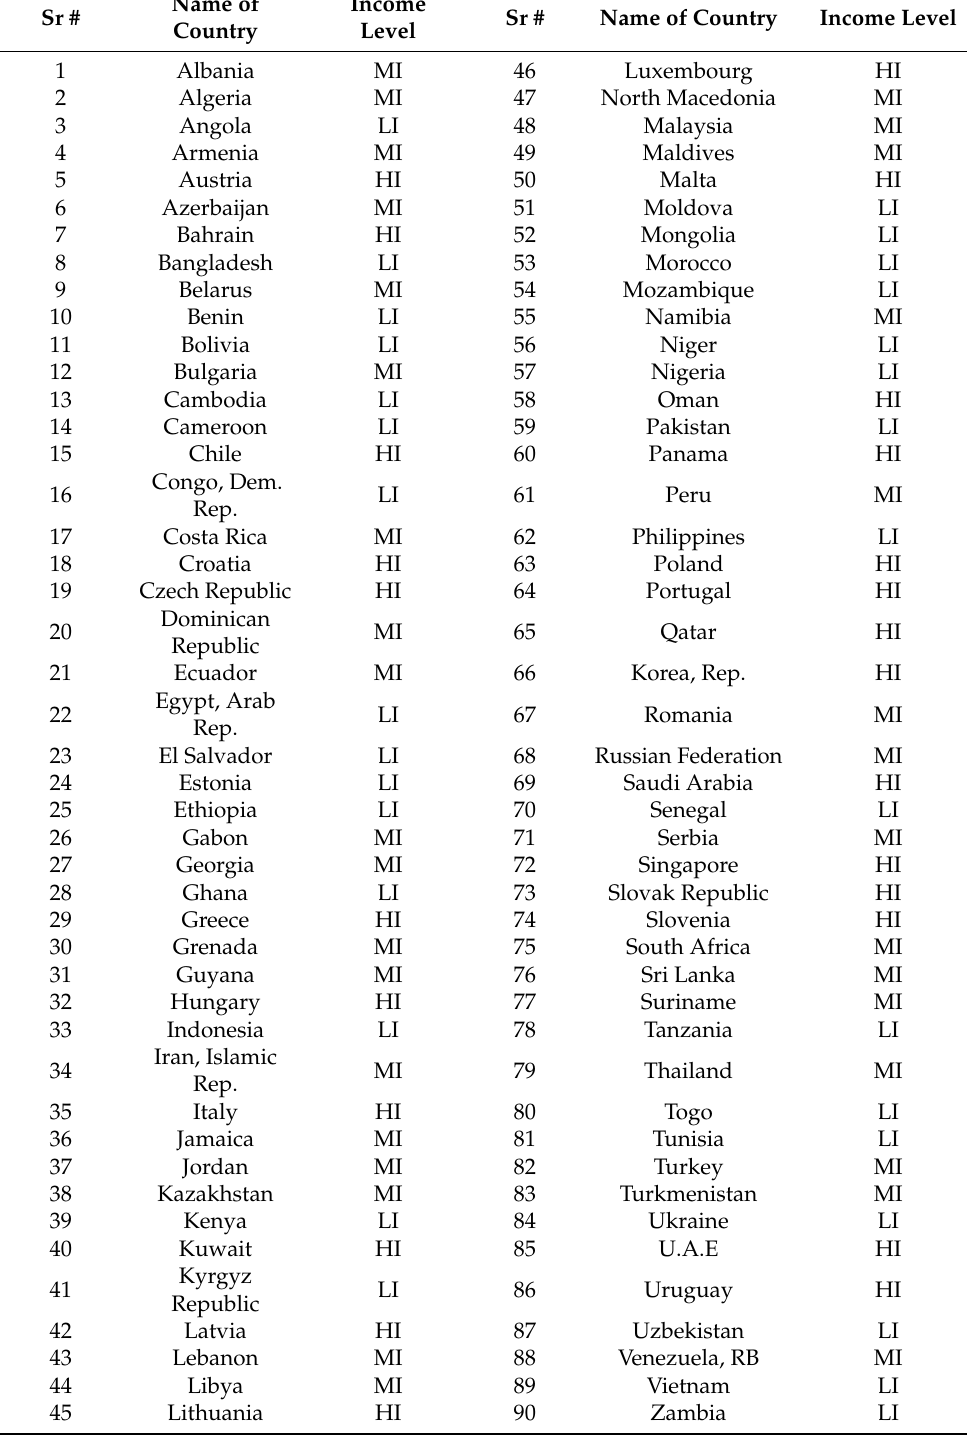
Table A1. List of Belt and Road Initiative